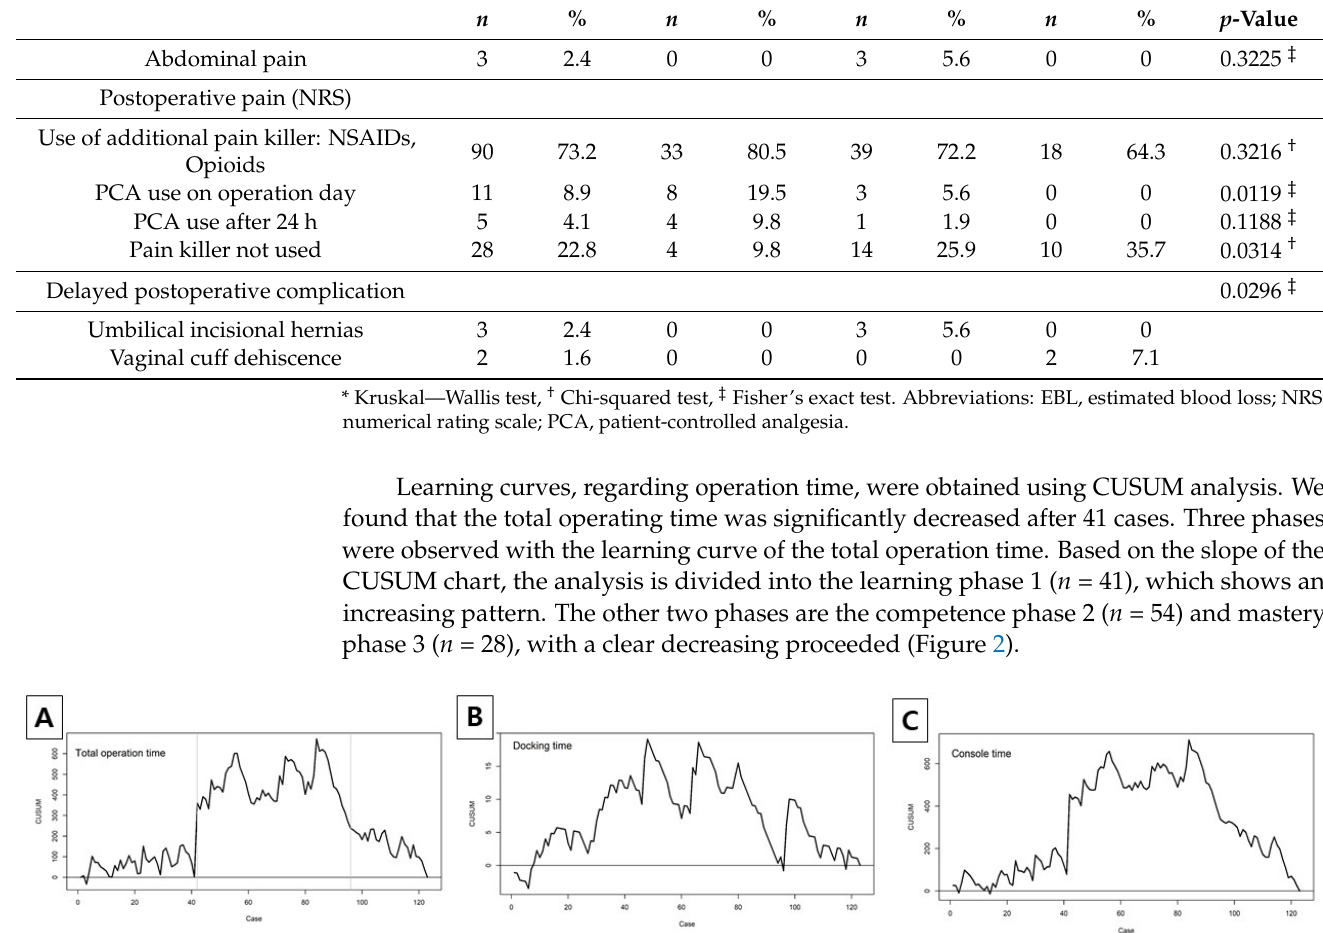
Table 3. Identification of factors affecting operation time using a linear regression model.